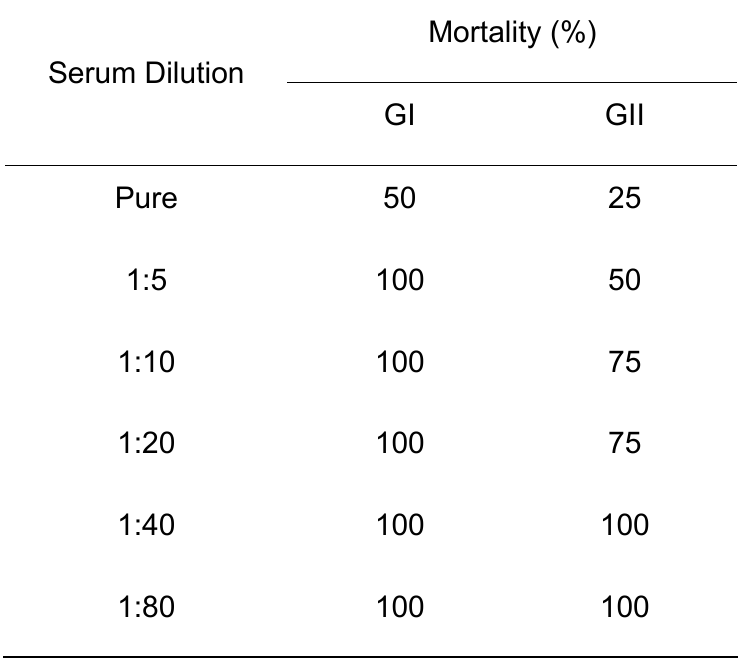
Table 2: Serum dilution for determination of the neutralizing capacity of Crotalus durissus terrificus antivenom prepared with native venom (GI) or irradiated venom